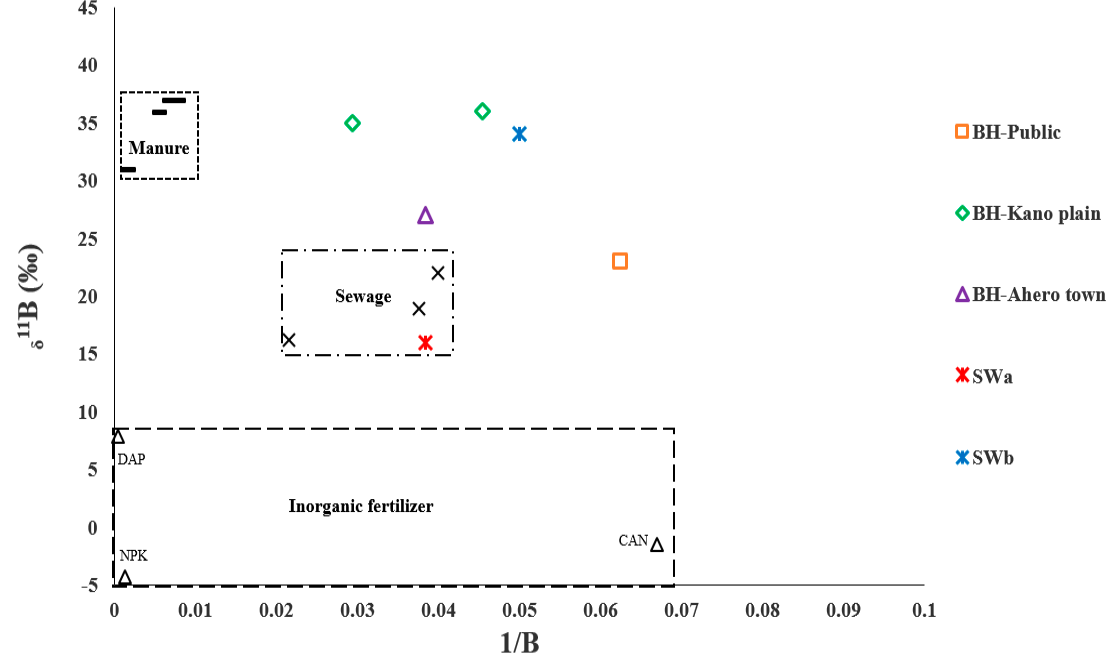
Figure 7. δ 11 B versus 1 / B concentration in selected borehole (BH) and shallow well (SW) samples. Value ranges of local sources of manure, sewage, and inorganic fertilizer are shown in boxes. BH-Public: boreholes in public institutions located in populated neighborhoods (brown squares); BH-Kano plain: boreholes located in the rural Kano (green diamonds); BH-Ahero town: boreholes situated in Ahero town (purple triangles); SWa: Kisumu shallow wells located in informal settlements (red stars); and SWb: Kisumu shallow wells located in newly planned estates (blue stars).